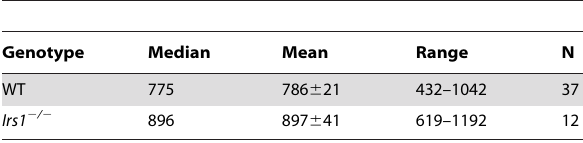
Table 2. Comparative survival characteristics of male wild type (WT) and Irs1 2 / 2